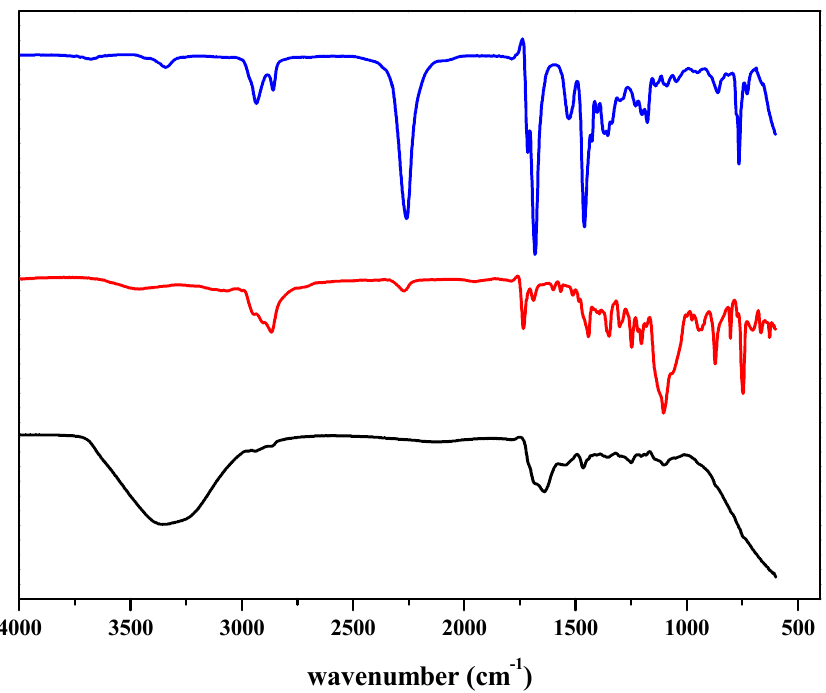
Figure 1. Representative FTIR spectra of (blue) HDI Trimer (red) EV 80 (black) WPU-g-BTA.